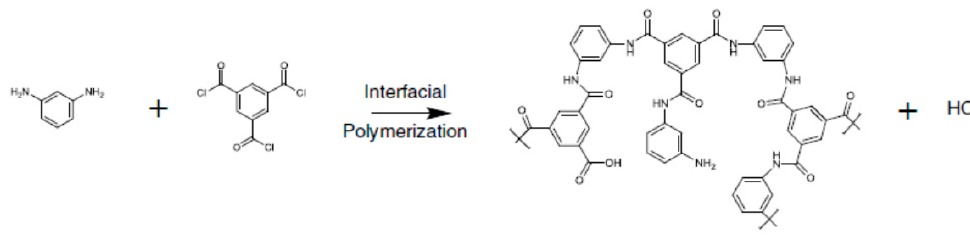
Figure 7. Interfacial polymerization between MPD (aqueous phase) and TMC (oil